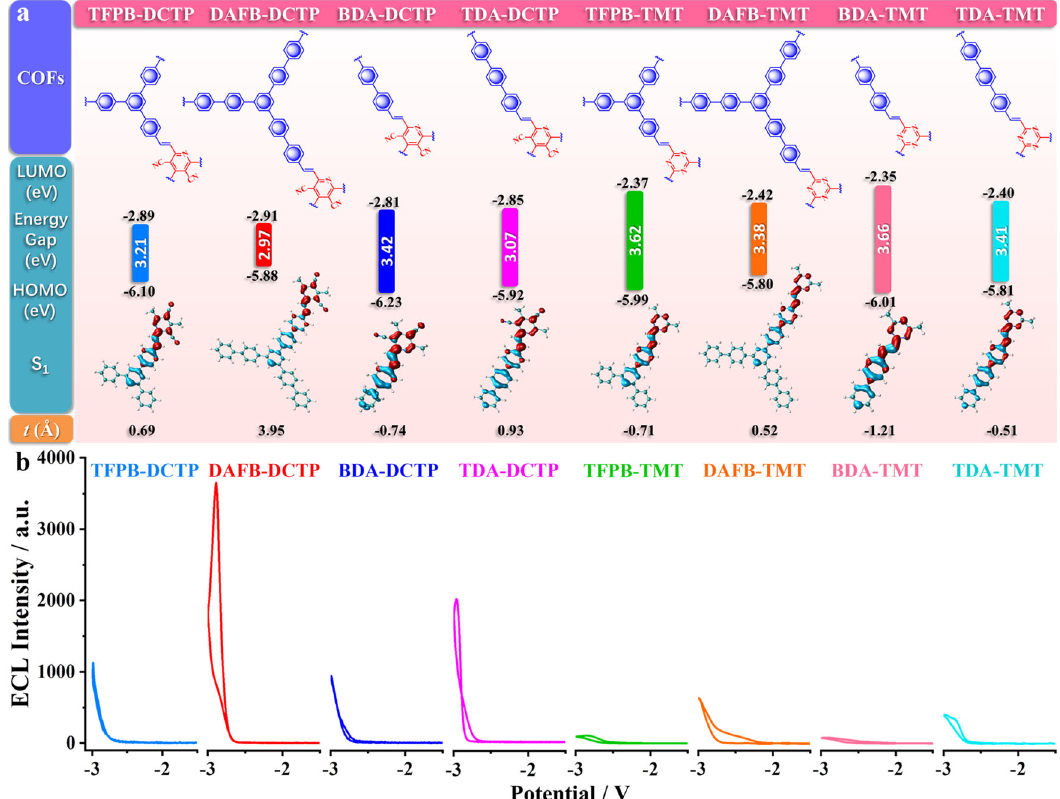
Fig. 4 In fl uence of chain length of COFs on ECL performance. a DFT calculations to the building blocks of COFs. The values of HOMOs, LUMOs, and calculated energy gaps and analysis for the distribution of the hole (blue) and electron (red) for S 1 are indicated. The t index is measured to evaluate the separation degree of hole and electron. b Comparison of ECL intensities of COFs in 0.1 M PBS with 0.1 M KCl between 0 V and − 3.0 V. PMT: 800 V, pH 7.5, potential scan rate: 100 mV s − 1